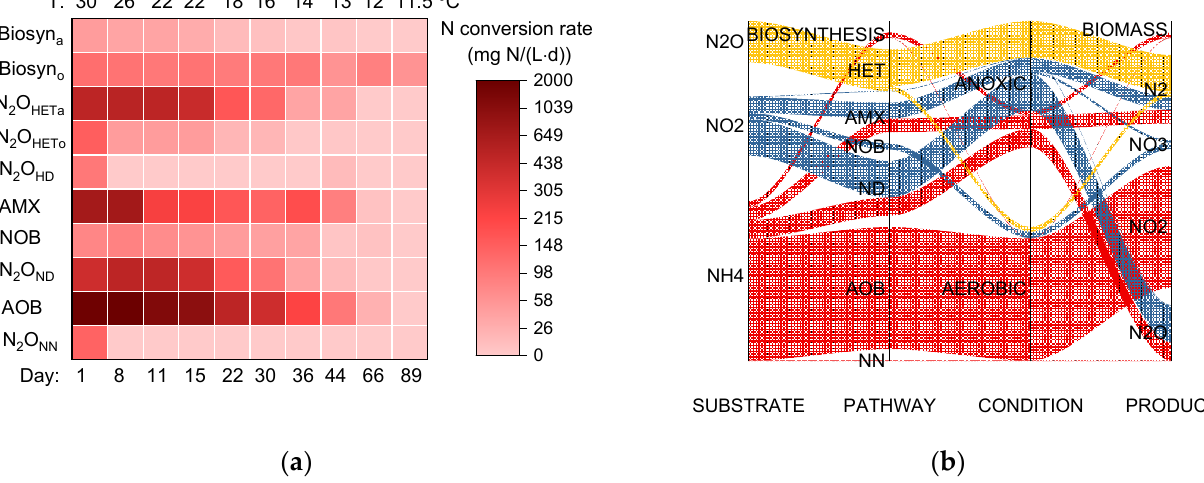
Figure 5. Significant N conversion pathways in the studied system: NH 4+ oxidation to NO 2- by AOB (AOB), NH 4+ and NO 2− consumption by anammox (AMX), NO 2− oxidation to NO 3− by NOB (NOB), N 2 O production by heterotrophs (N 2 O HD ), N 2 O production by nitrifier denitrification (N 2 O NN ), N 2 O production by nitrifier denitrification (N 2 O ND ), N 2 O consumption by heterotrophs under anoxic and aerobic conditions (N 2 O HETa, N 2 O HETo ), biosynthesis using NH 4+ to grow biomass under anoxic and aerobic conditions (Biosyn a ,BioSyn o ). ( a ) Heatmap of the N conversion pathways in the temperature range 30–11 °C, in which the darker color means higher N conversion rate; ( b ) Sankey graph of the pathway contribution of the N equivalents at 22 °C after recovery, which shows the balance between the major N compounds and their conversions.